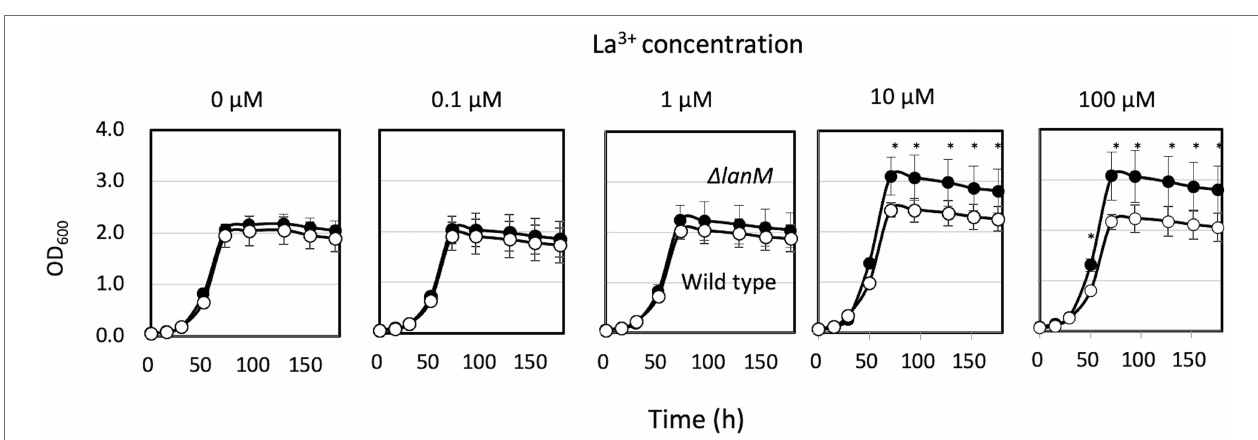
FIGURE 3 | Growth of strain 22A wild type and Δ lanM on methanol under varied concentrations of LaCl 3 . Filled symbols, wild type; open symbols, Δ lanM . Data are presented as the mean value ± standard deviation (SD; n = 3). The data were analyzed with two-way ANOVA followed by Sidak’s multiple comparisons test. * p <